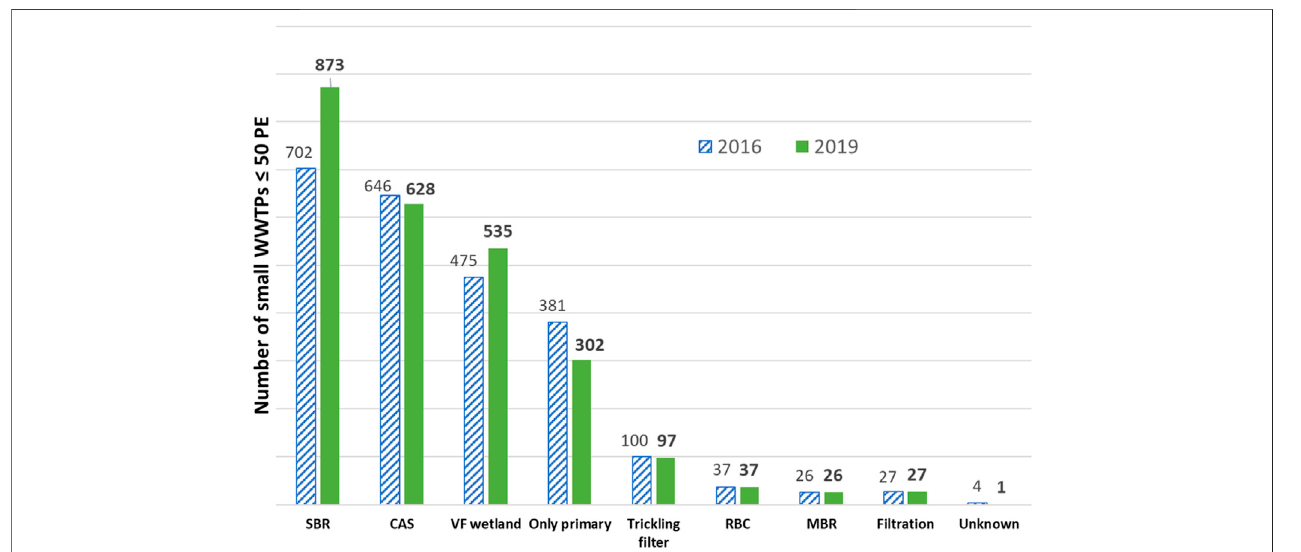
FIGURE 1 | Development of the number of small WWTPs in Upper Austria (adapted from Engstler, 2020).